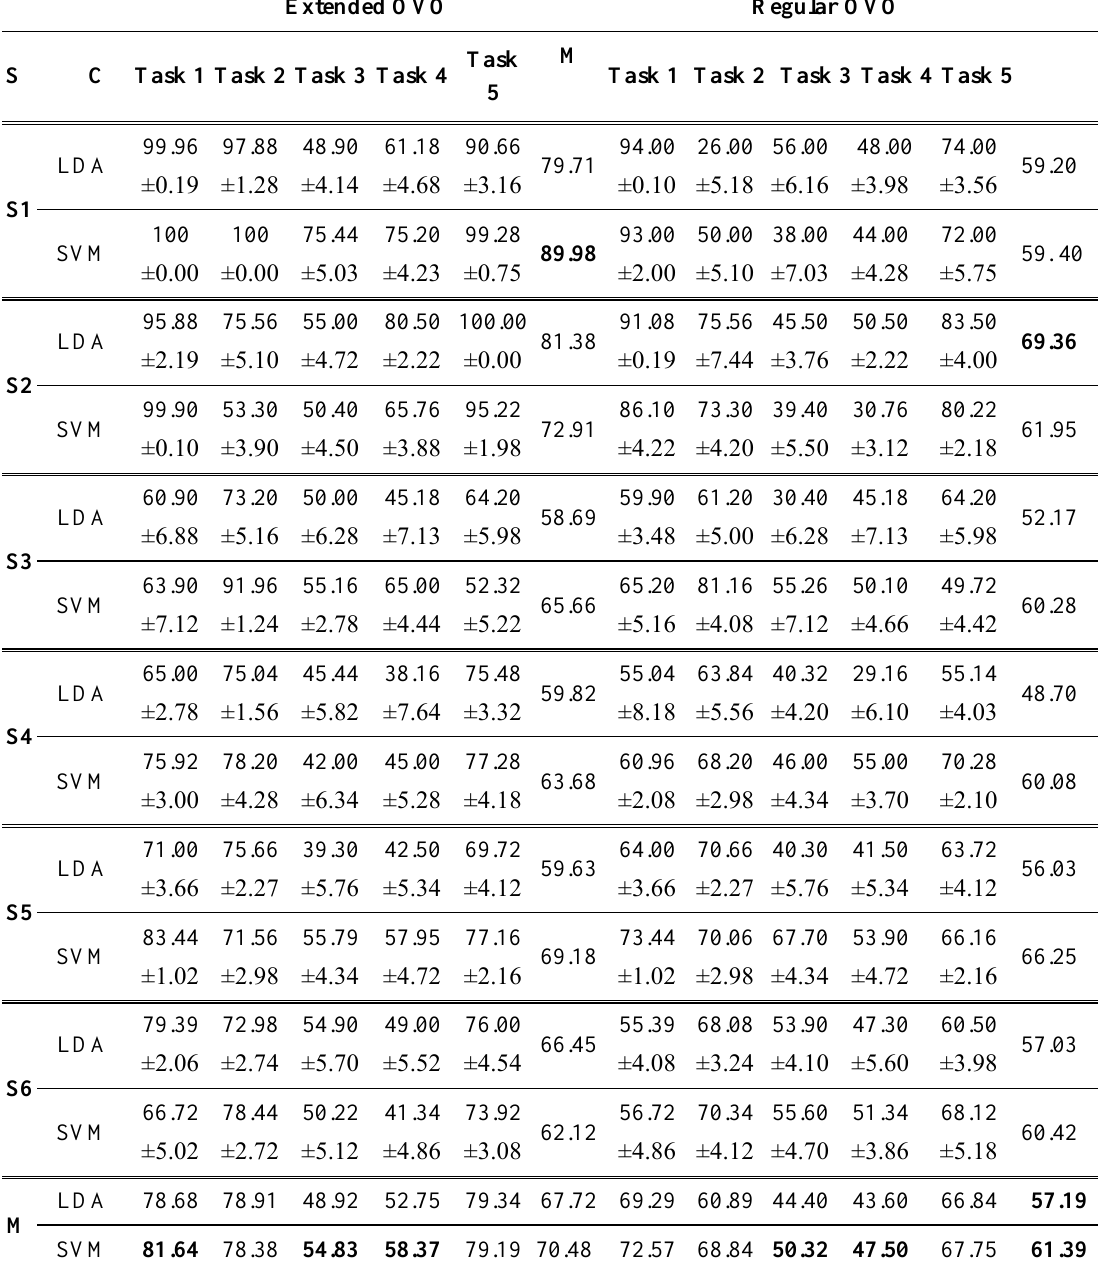
Table 2. Multi-class classification results with standard deviations for 9 electrodes with extended OVO and regular OVO approaches. S:Subjects, C:Classifiers,